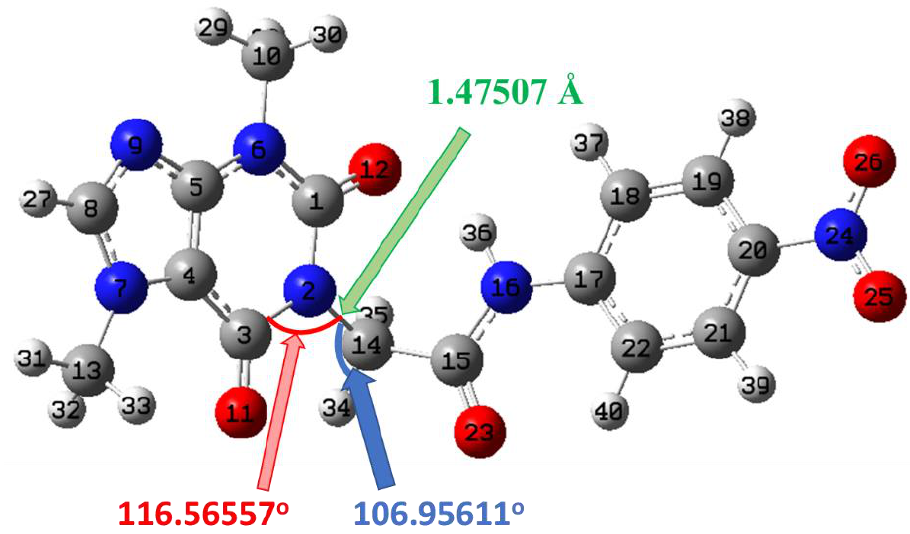
Figure 11. The optimized chemical structure of T-2-PNPA at B3LYB/6-311G++(d,p) basis set. Table 2. The calculated global reactivity indices and energetic parameters for T-2-PNPA